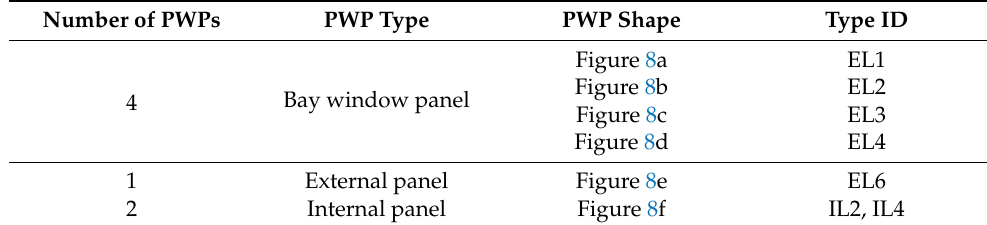
Table 4. The types of information for the scanned PWPs.